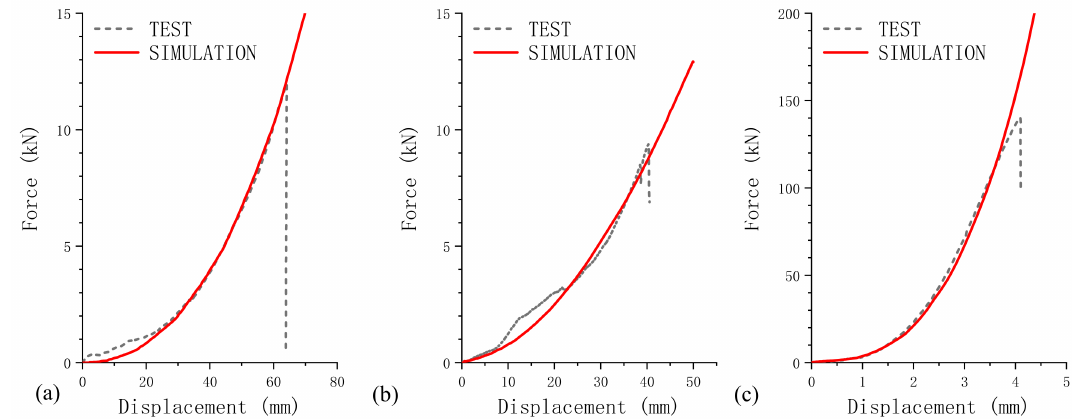
Figure 7. Simulation results without failure criterion along three directions: ( a ) X direction; ( b ) Y direction; ( c ) Z